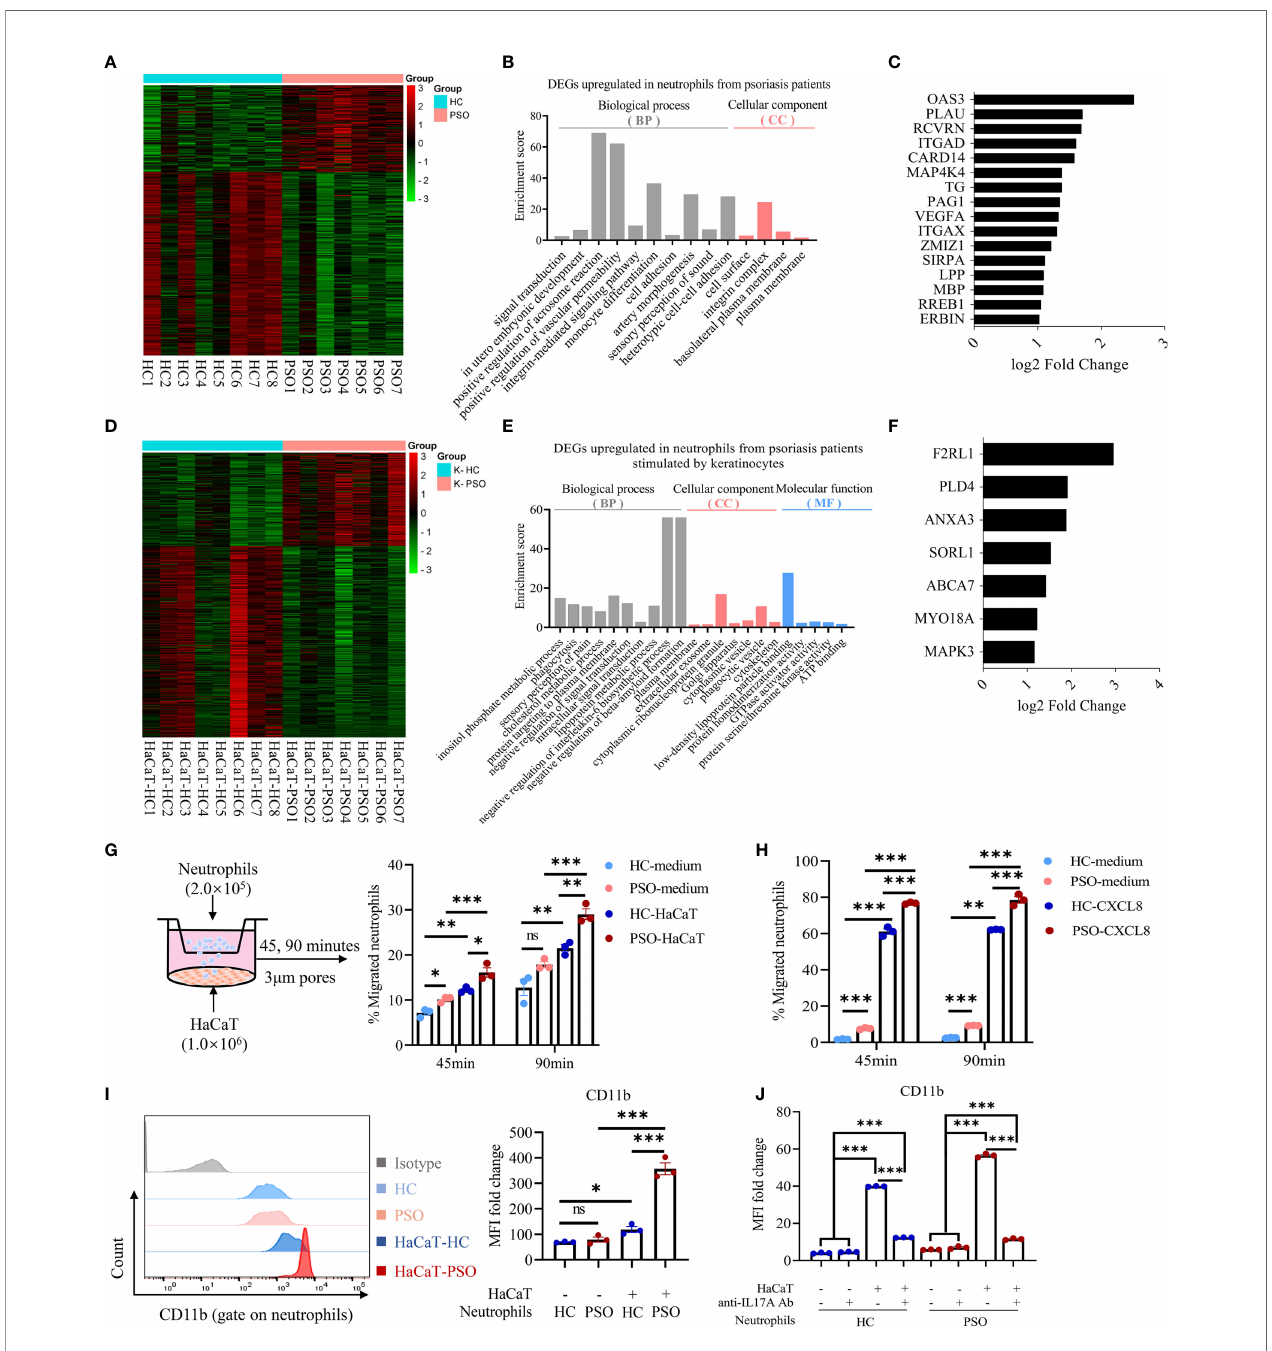
FIGURE 4 | Neutrophils gain migration phenotype and capacity after coculture with keratinocytes. (A) Heatmap showing DEGs of RNA-Seq results in PSO (n = 7) versus HC (n = 8) neutrophils cultured alone for 8 h. (B) GO category and (C) migration-related DEGs upregulated in PSO neutrophils. (D) Heatmap showing DEGs in PSO versus HC neutrophils after indirect coculture with HaCaT for 8 h. (E) GO category and (F) phagocytosis-related DEGs upregulated in PSO neutrophils. (G) A scheme of transwell assay. Peripheral blood neutrophils (2 × 10 5 cells) in the upper chamber were allowed to migrate through 3 m m pores of transwell membrane towards the lower chamber with complete medium or pre-seeded with HaCaT, and the rates of neutrophils migration at indicated time points were analyzed by fl ow cytometry. HC-medium, HC neutrophils with medium, PSO-medium, PSO neutrophils with medium, HC-HaCaT, HC neutrophils with HaCaT, PSO neutrophils with HaCaT. (H) Transwell assay comparing the migration of HC or PSO neutrophils towards complete medium with or without CXCL8 protein (200 ng/ml). (I) Representative images of fl ow cytometry and quanti fi cation of MFI fold changes of CD11b expression on neutrophils cultured with or without HaCaT in an indirect manner for 24 h. (J) Quanti fi cation of MFI fold changes of CD11b expression on neutrophils cultured as described in (I) with or withoutanti-IL-17A Abs (12.5 m g/ml). Data are presented as mean ± SEM, one-way ANOVA. *p < 0.05; **p < 0.01; ***p < 0.001. DEGs, differently expressed genes; GO, Gene Ontology; MFI, median fl uorescence intensity; ns, not signi fi cant; RNA-Seq,